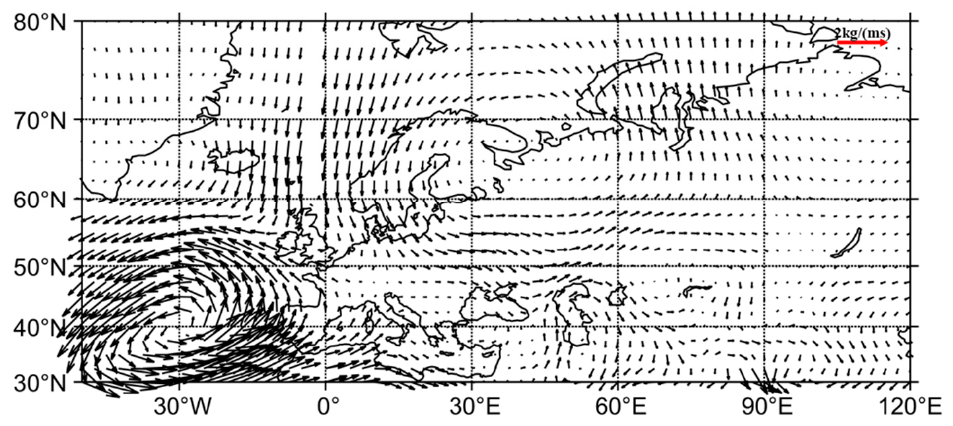
Figure 11. The abnormal spring water vapor flux when the Barents–Karas sea ice concentration is at a low value, unit: kg m − 1 s − 1 .